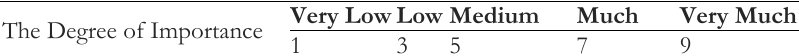
Table 3. Scoring of the importance.